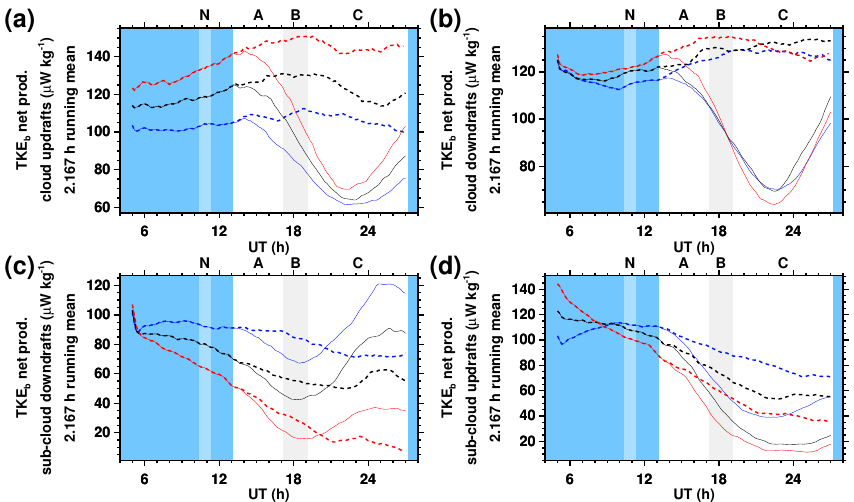
Figure 10. Wind speed and the diurnal cycle. Time series from simulations M − (blue), M 0 (black), M + (red), solid curves, and from simulations M − (blue), M 0 (black), M + (red), dashed curves. TKE production rates are given per total boundary layer air mass. A dark dark dark low-pass (running mean) filter was applied where indicated to reduce noise.